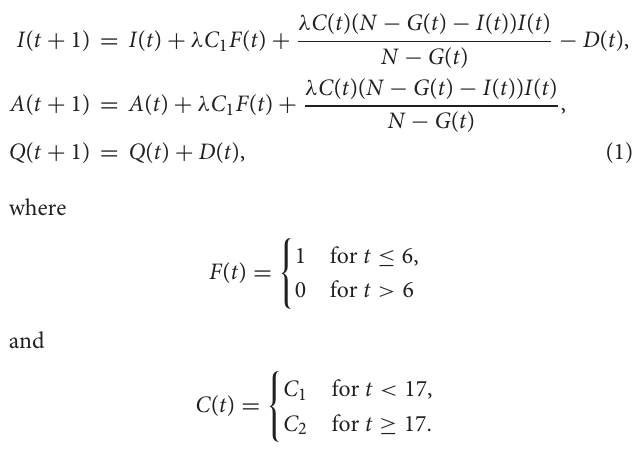
FIGURE 2 | Transfer diagram for the dynamical transmission of COVID-19 among